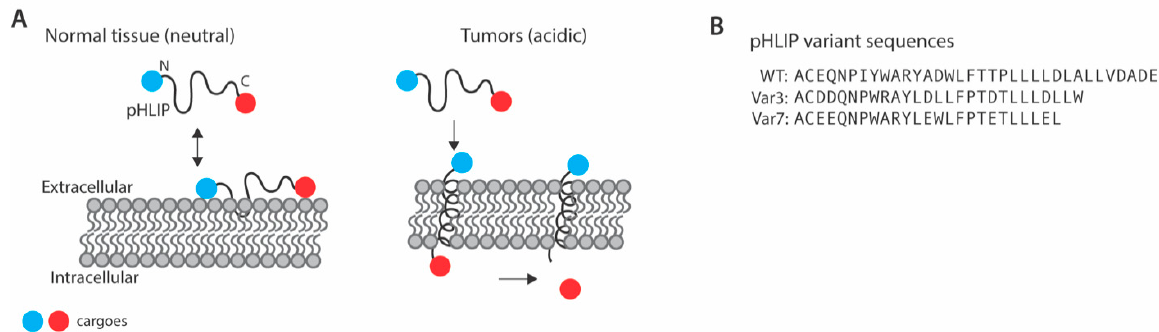
Figure 1. pH-low insertion peptide (pHLIP) mechanism of action. ( A ) Mechanism of action for tumor-specific delivery of cargo or labeling of cell membranes using pHLIP. ( B ) Amino acid sequences of pHLIP and selected pHLIP variants.